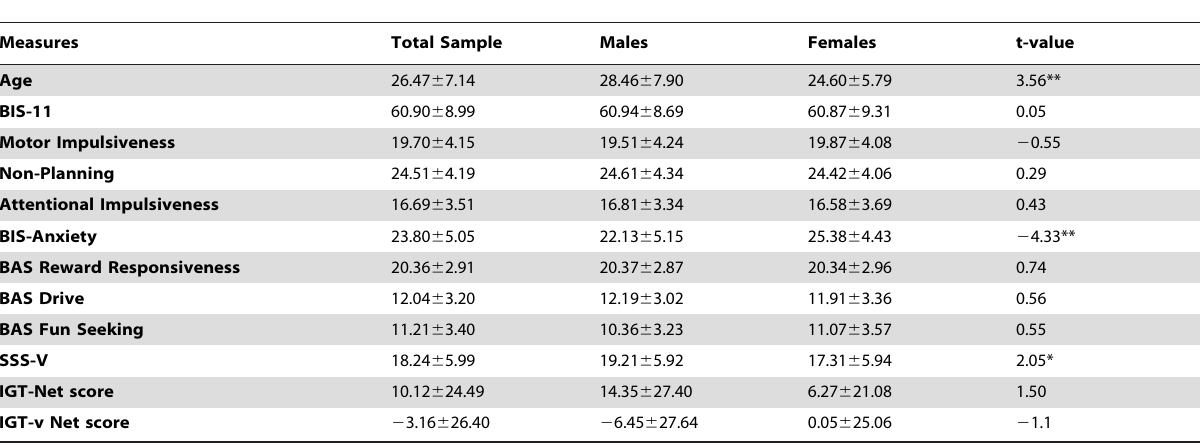
Table 1. Descriptive statistics (mean 6 SD) of personality measures and task performance.